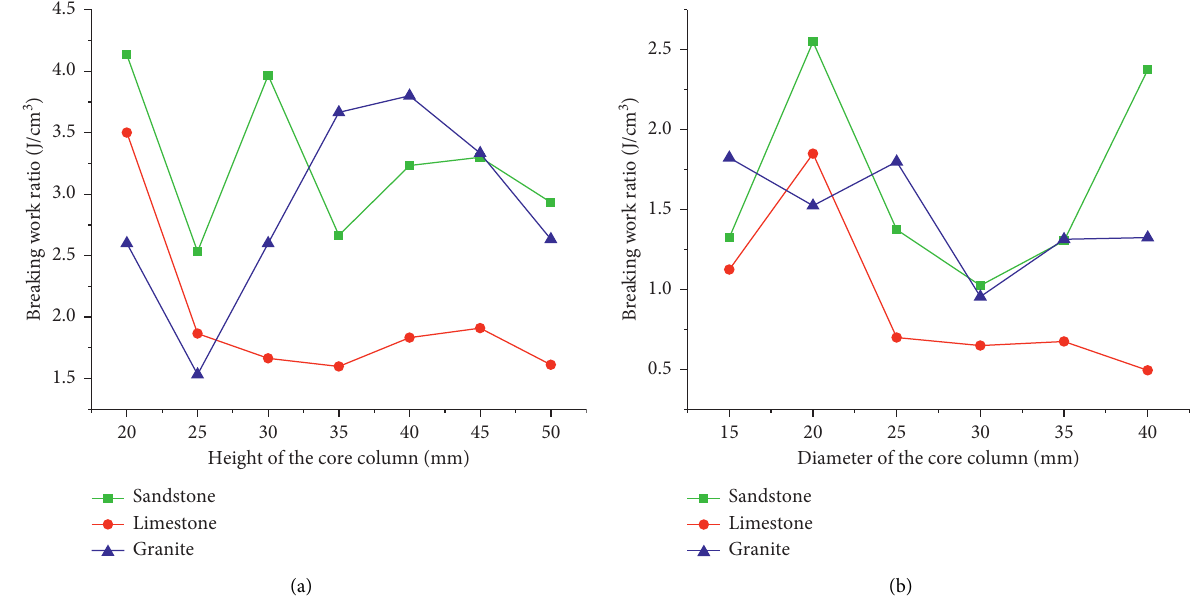
Figure 16: Effects of the breaking work ratio on the size of core columns in the impact